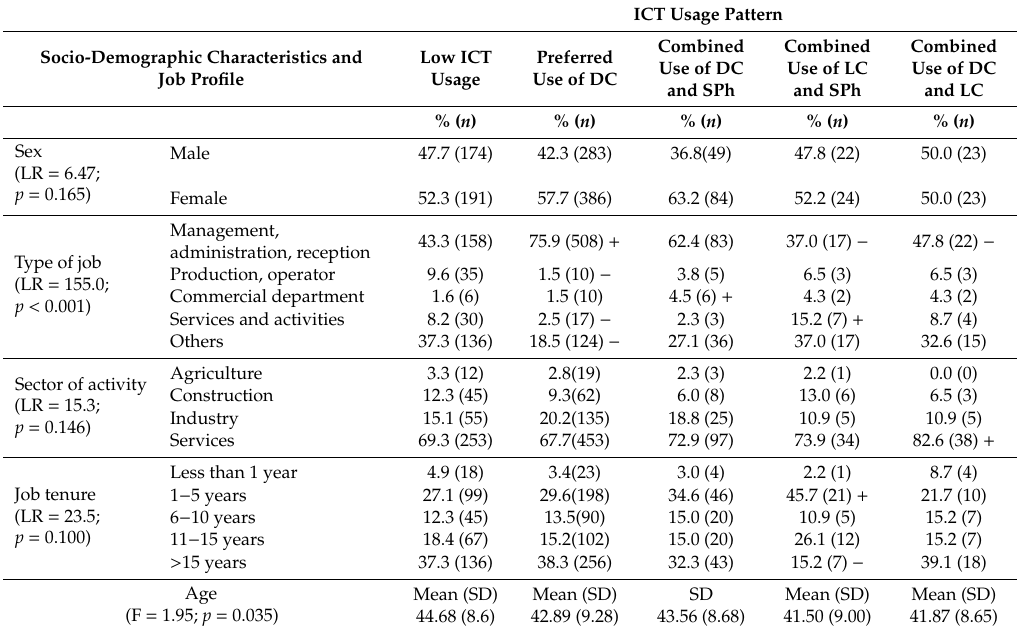
Table A1. Socio-demographic characteristics and job profile of ICTs usage